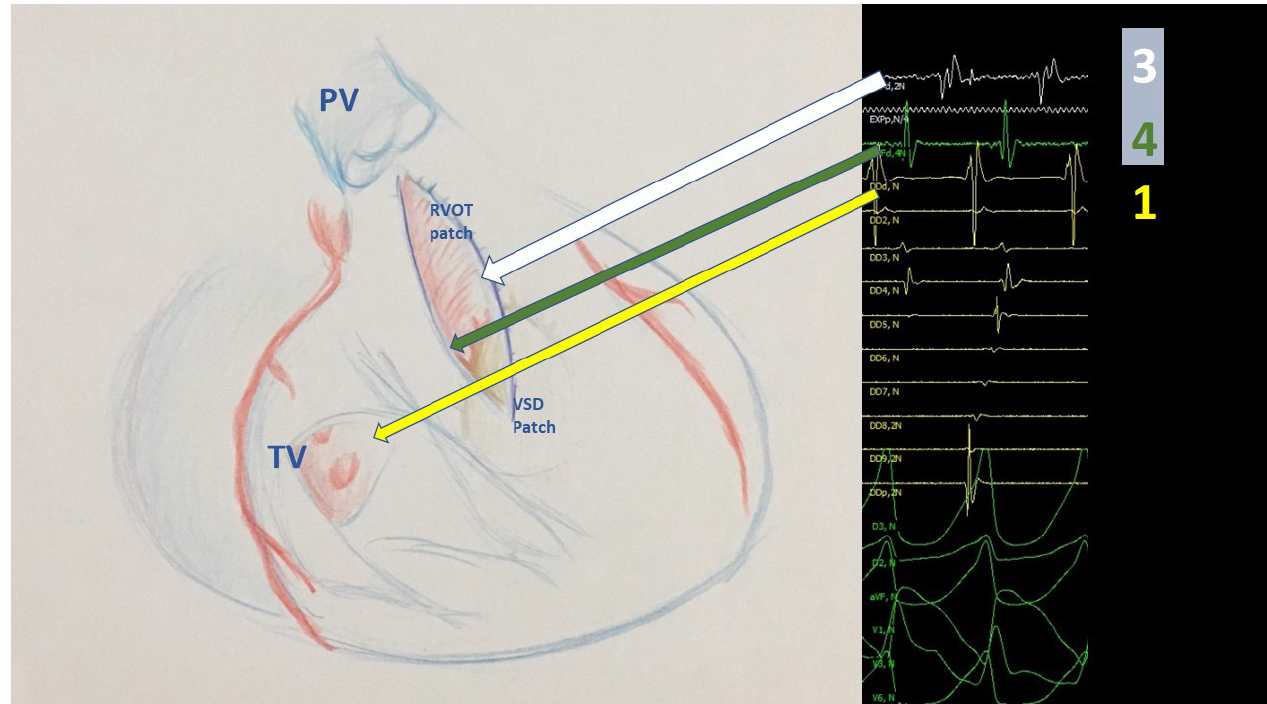
Fig. 1 – Disposition of catheters during EPS in search of mid-diastolic potentials. Proximal 20 – pole deflectable catheter – in yellow – on isthmus number 4 (between septal tricuspid valve and VSD patch. Ablation catheter – white line – on isthmus number 3 (between pulmonary valve and VSD patch), Quadripolar catheter – green line – on isthmus number 1 (between infundibulectomy and lateral tricuspid valve). There was no intention in mapping possible isthmus number 2 because the first surgery was performed along the pulmonary valve, thus surgically connecting the infundibulectomy patch with the pulmonary artery and then replacing it for the pulmonary prosthesis. PV = pulmonary valve; RVOT = Right ventricular outflow tract; TV = tricuspid valve; VSD = ventricular septal